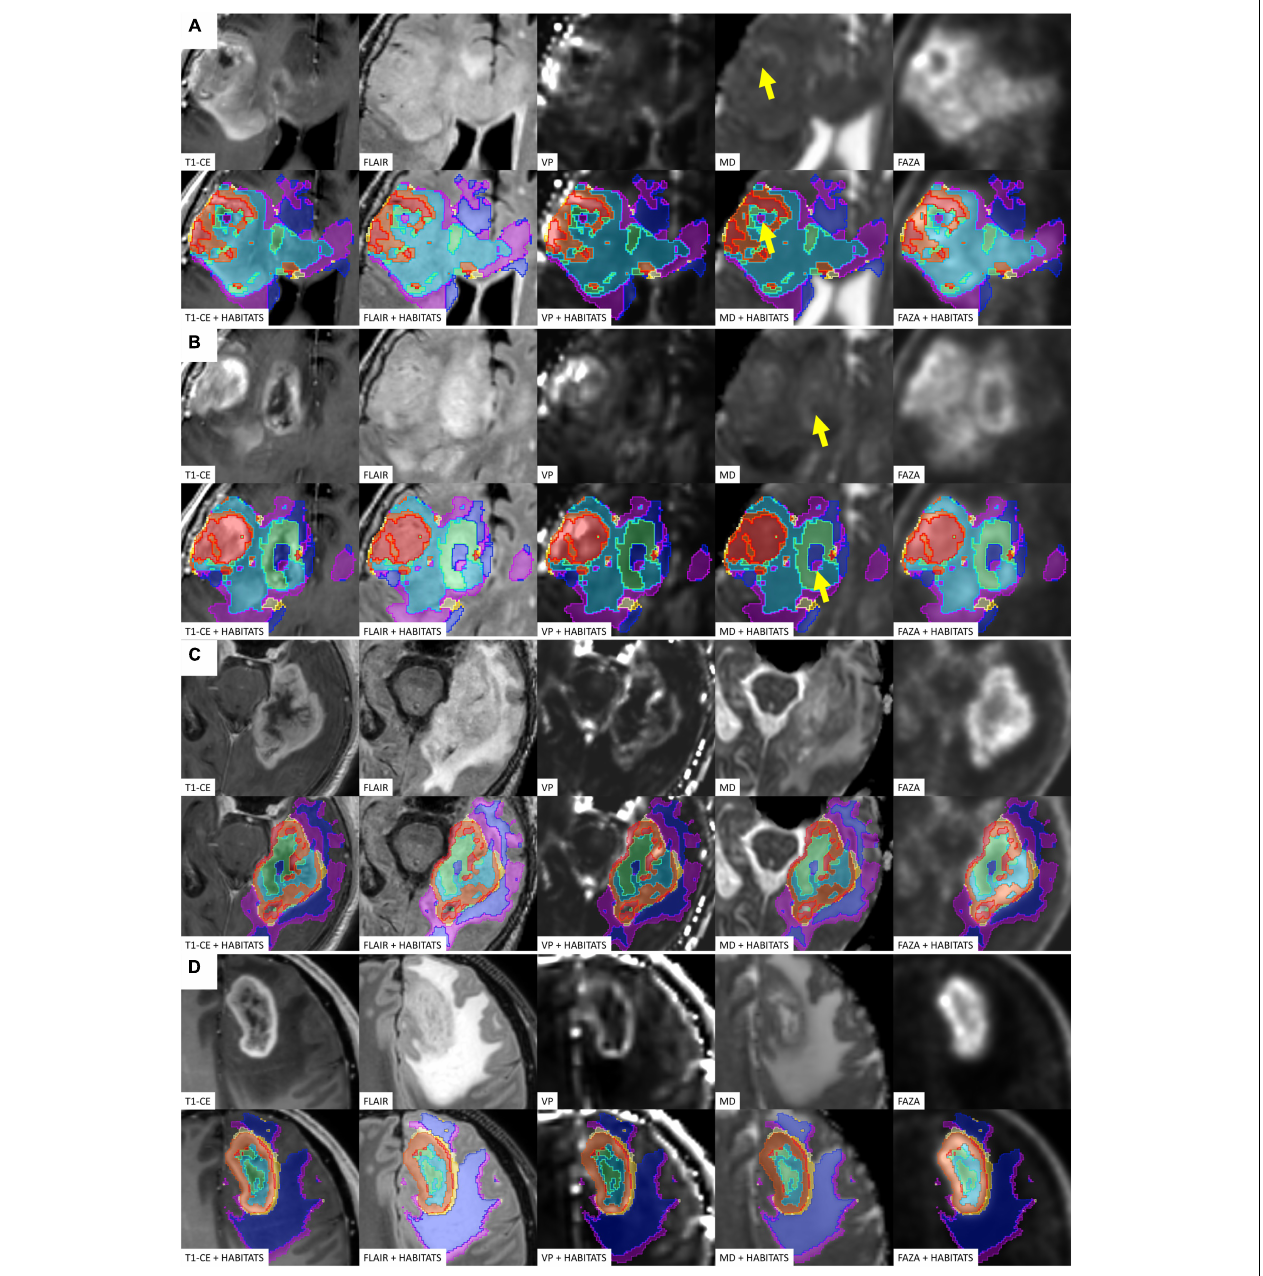
FIGURE 4 | Four different illustrative cases (A–D) showing habitats distribution and reproducibility of spatial habitat imaging maps. A table listing the key colors (1–red, 2–orange, 3–gold, 4–yellow, 5–aquamarine, 6–light blue, 7–dark blue, and 8–violet) assigned to each habitat is reported in Figure 5 . The yellow arrows shows point areas of microhemorragic foci resulting in a MD signal